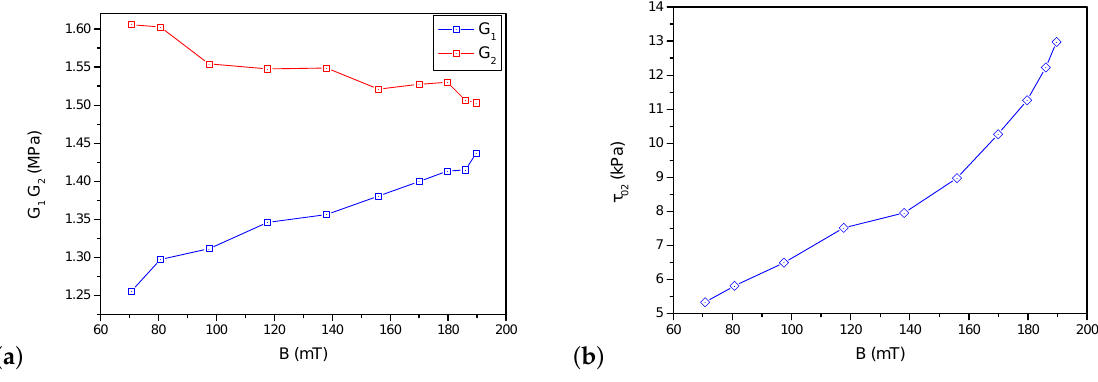
Figure 7. Identification results. Model parameters as a function of magnetic field value: ( a ) stiffness G 1 and G 2 ; and ( b ) yield point τ o 2